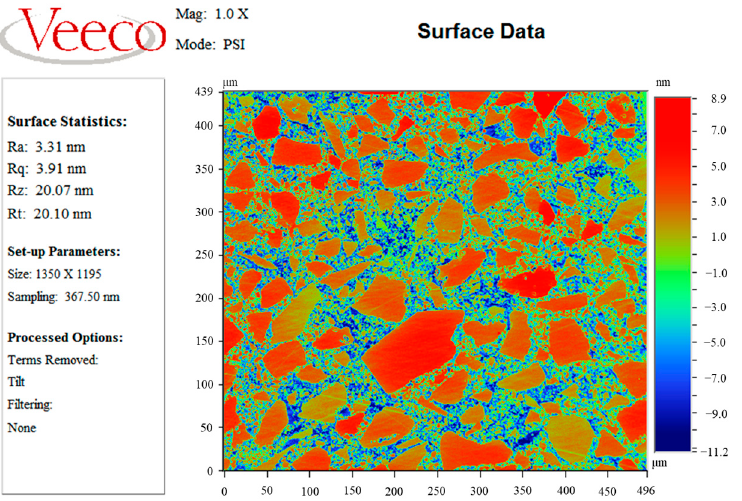
Figure 22. Surface form error of the SiC aspheric mirror after CCOS.